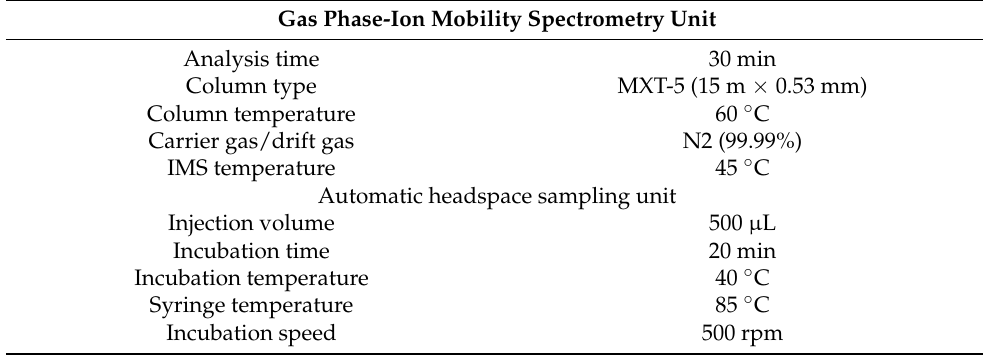
Table 1. Experimental conditions for smoke-flavored sea bass analysis by